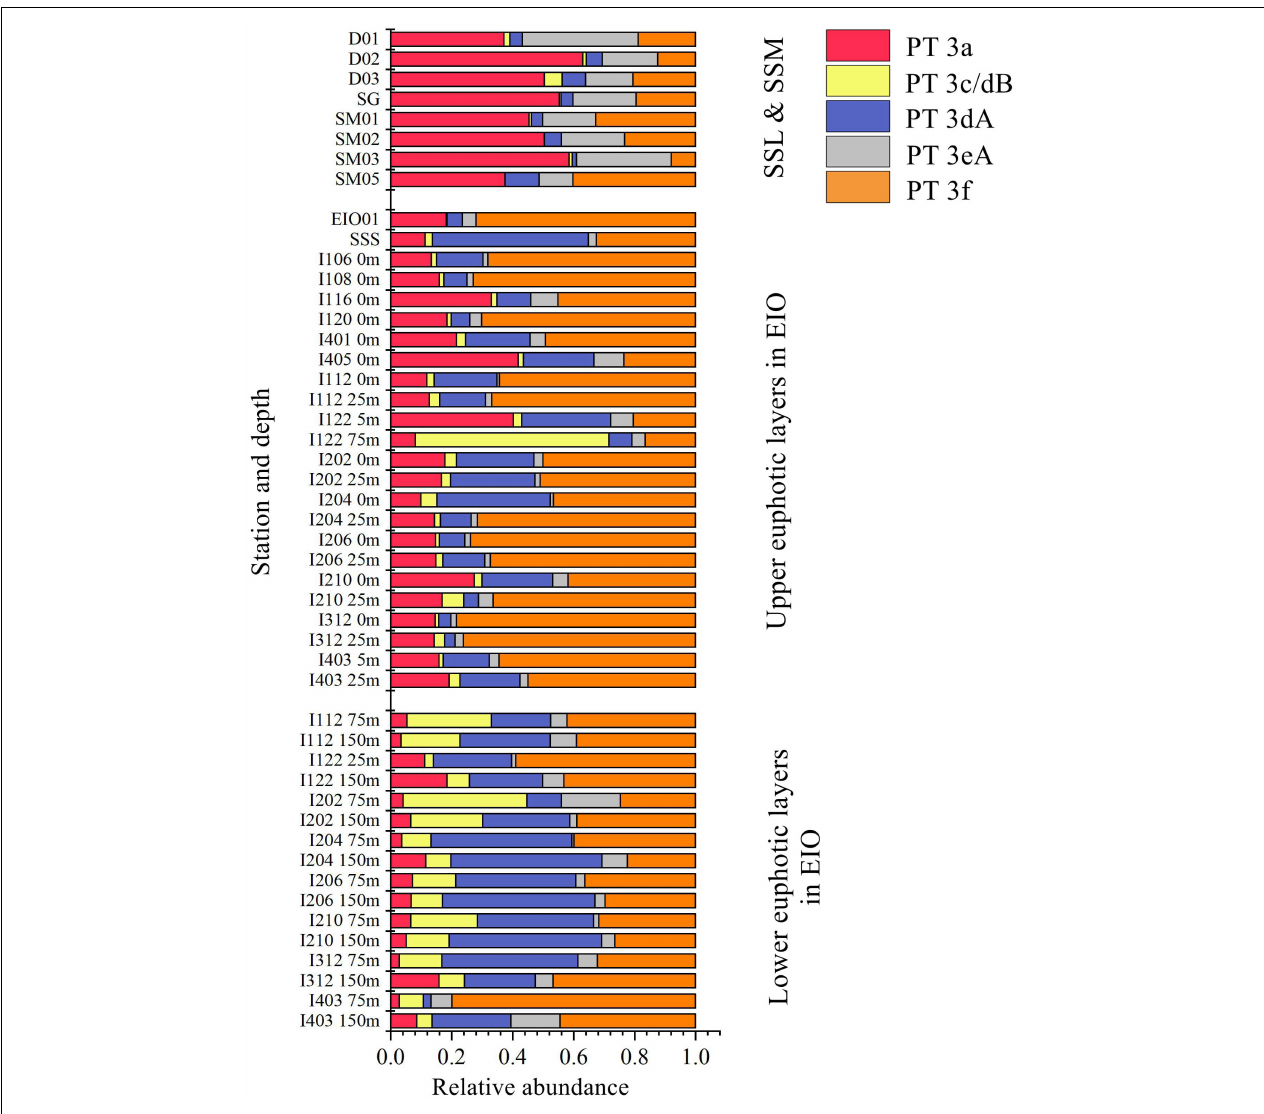
FIGURE 6 | Community structure of Synechococcus pigment types in different depths and sampling sites eastern Indian Ocean (EIO), Sri Lanka coastal waters, and Strait of Malacca (SSL, surface water of Sri Lanka coastal waters; SSM, surface water of Strait of Malacca; SSS, Surface water of station Shelf of Sunda).